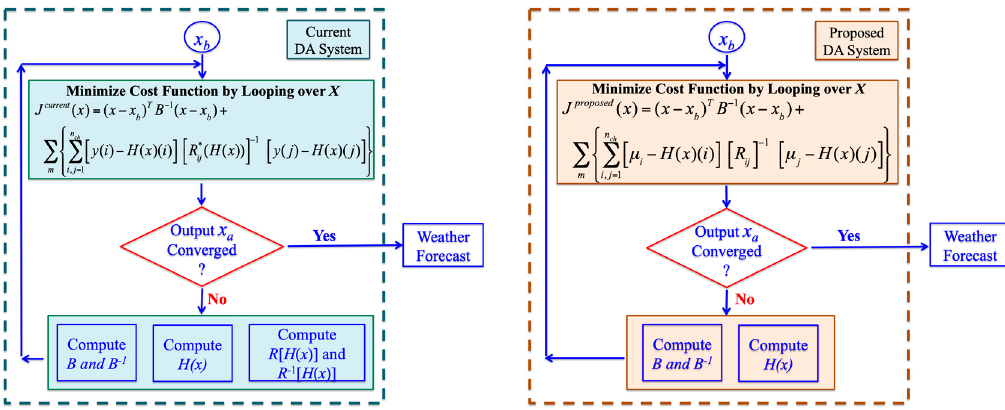
Figure 2. ( a ) Current data assimilation (DA) system (left) versus ( b ) proposed DA system (right), where the DA systems are indicated inside dashed squares. Note that R ∗ can be either R D or R d in the current DA system.